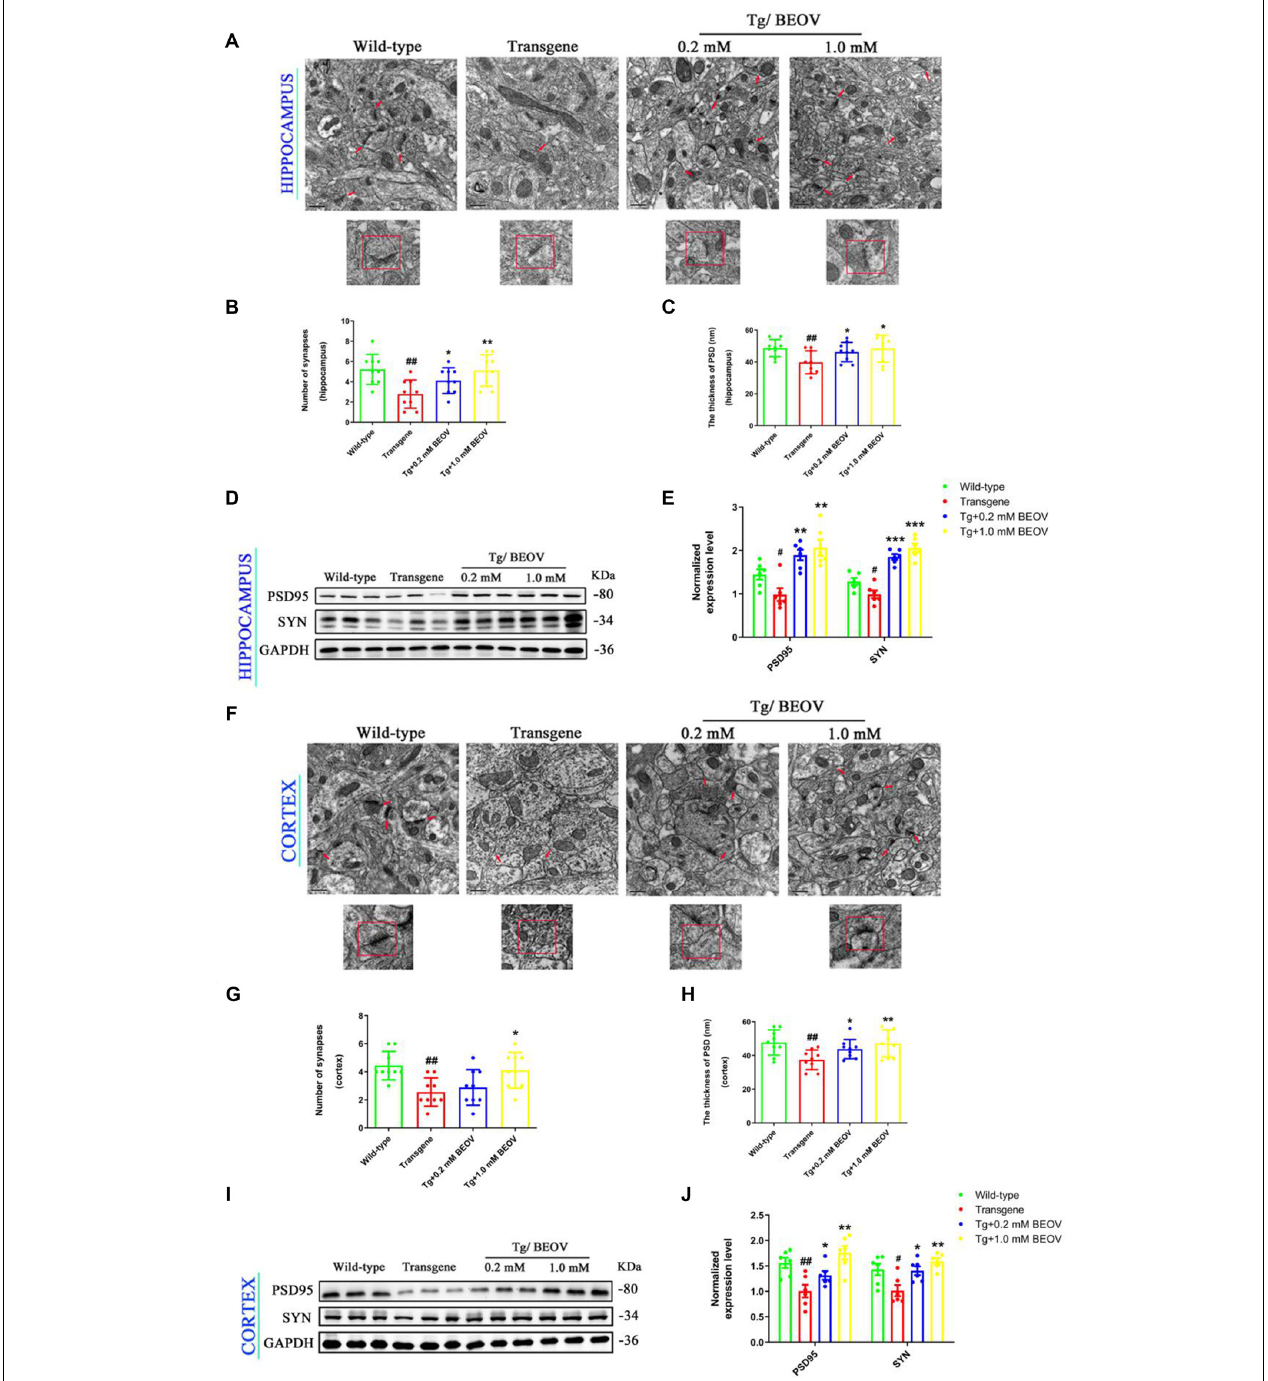
FIGURE 3 | BEOV protected hippocampal and cortical synapses in APPSwe/PS1dE9 mice. (A,F) Synapses in the cornu ammonis 3 (CA3) region of the hippocampus and the layer V region of cortex of WT, APPSWE/PS1DE9, and BEOV-treated APPSwe/PS1dE9 mice were imaged by transmission electron microscopy (TEM). Scale bar = 0.5 µ m. (B,G) Quantitative graph of the numbers of synapses in equal areas. The numbers of synapses were counted in three fields of view on each ultrathin section, and three ultrathin sections from different mice in each group were analyzed. (C,H) Quantitative analysis of the thickness of postsynaptic density (PSD) in each group. # WT vs. AD; *AD + BEOV vs. AD. n = 3, # P < 0.05, ## P < 0.01, * P < 0.05, and ** P < 0.01, respectively. (D,I) and (E,J) Western blot analyses and semi-quantification of proteins containing synaptophysin (SYN) and postsynaptic protein (PSD95) in the hippocampus and cortex of mice at the age of 9 months. Quantitative results were normalized against the levels of GAPDH. # WT group vs. AD group; *AD + BEOV group vs. AD group. n = 6, three females and three males; # P < 0.05, ## P < 0.01, * P < 0.05, ** P < 0.01, and *** P < 0.001, respectively.